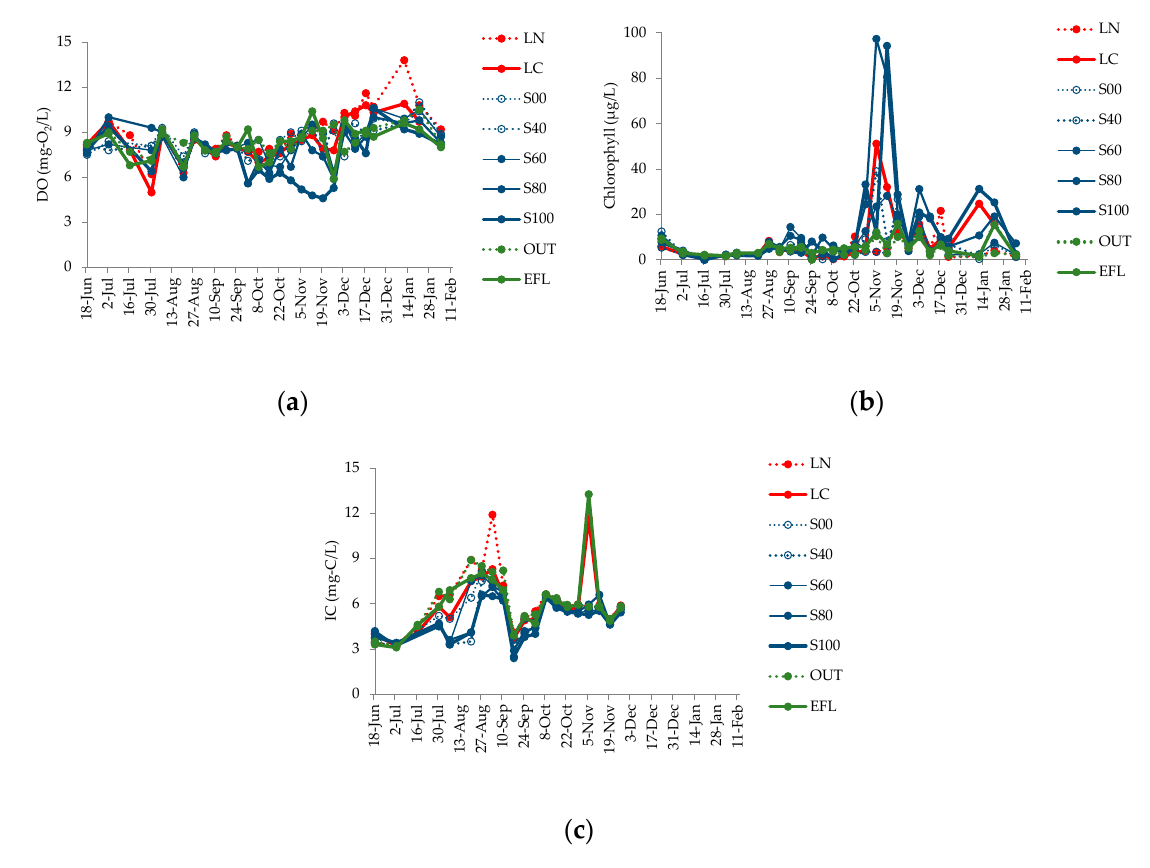
Figure 8. Changes in ( a ) DO; ( b ) chlorophyll; ( c ) IC.